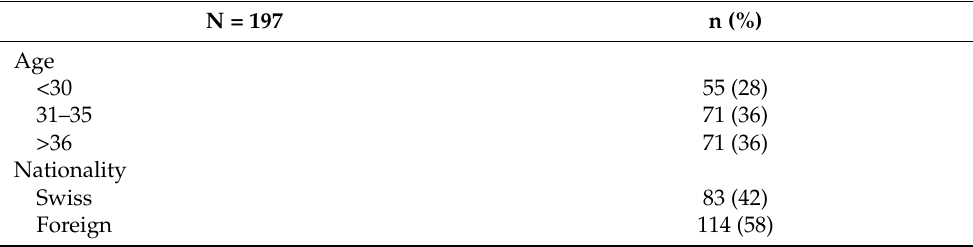
Table 1. Demographic characteristics of the